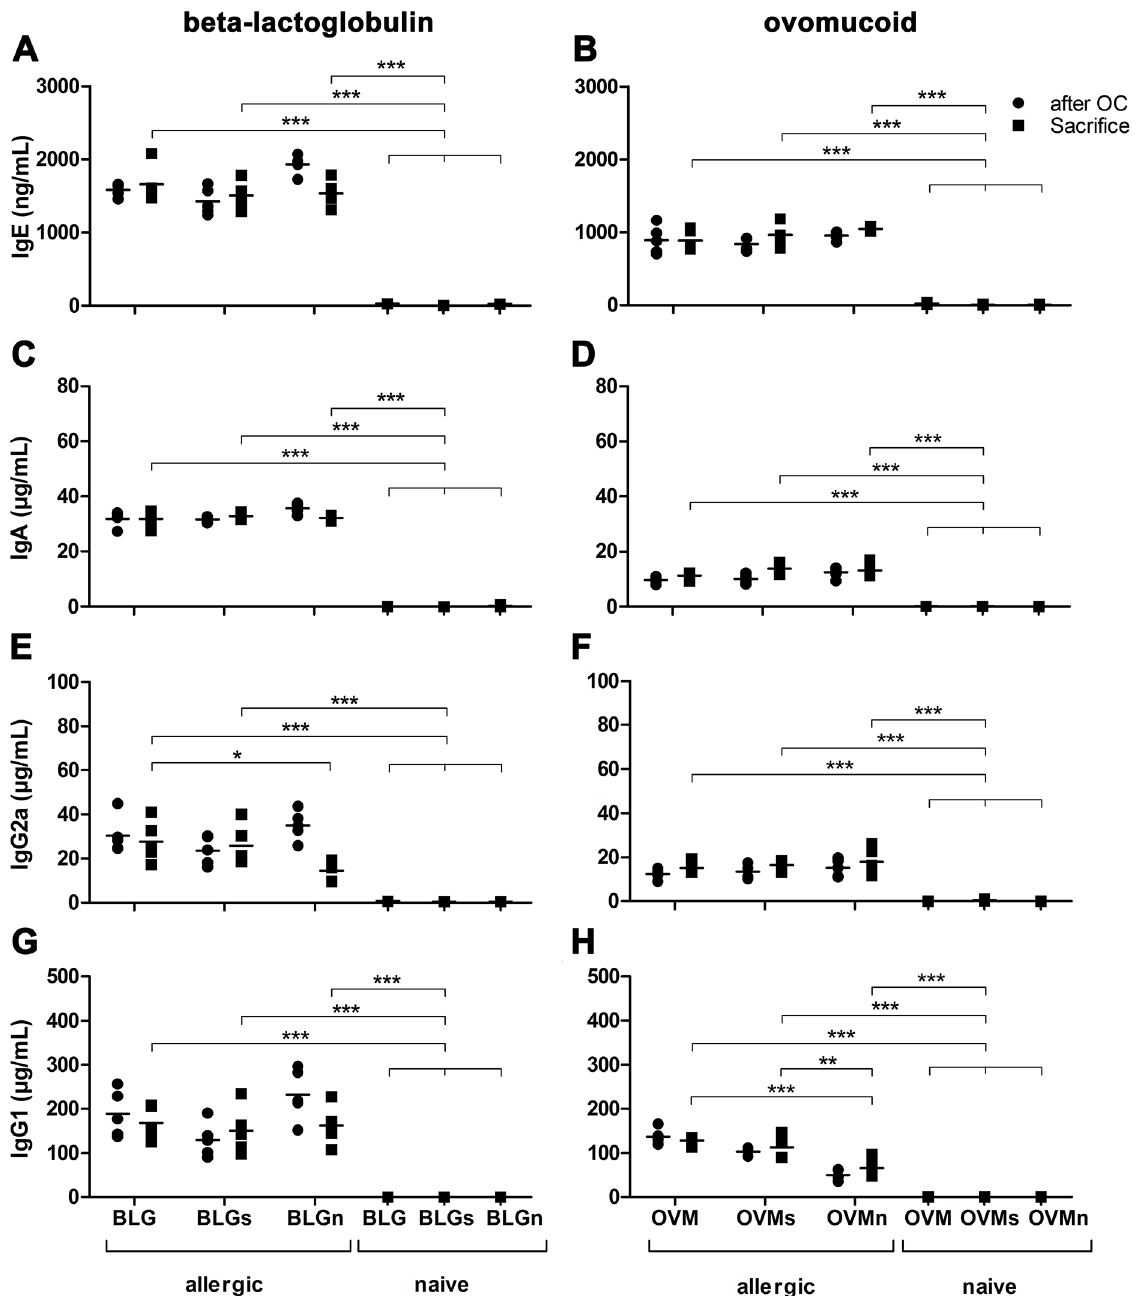
Fig 2. Induction of allergen specific IgE, IgA, IgG1 and IgG2a in immunized mice. Immunization elicited equally elevated specific IgE titers in mice being injected with the same allergen (A, BLG; B, OVM) whereas na ï ve control groups did not show any allergen specific IgE antibody production. BLG (C, E, G) and OVM (D, F, H) allergic mice showed significantly higher levels of allergen specific IgG1, IgG2a and IgA compared with na ï ve mice. Significantly lower levels of specific IgG2a were observed in the group i.v. challenged with nitrated BLG (BLGn). Significantly lower levels of specific IgG1 were found in the group i.v. challenged with nitrated OVM (OVMn). Independent of the isotype, higher antibody levels were found in mice sensitized with BLG compared to OVM sensitized animals. Data obtained for IgG2a of OVM allergic mice were transformed by applying the logarithm to base 10. Antibody levels of groups were compared at the time-point of sacrifice with One-way ANOVA followed by Tukey post test. ( ** P < 0.01, *** P < 0.001) BLG, beta-lactoglobulin; BLGn, nitrated BLG; i.v., intravenous; OVM, ovomucoid; OVMn, nitrated OVM